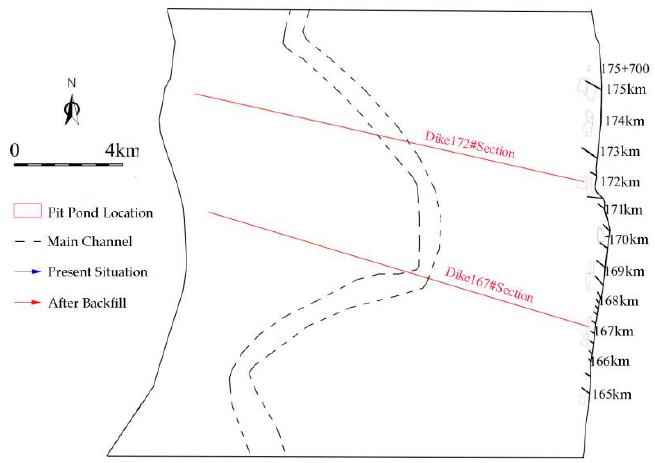
Figure 11. The cross-section position.